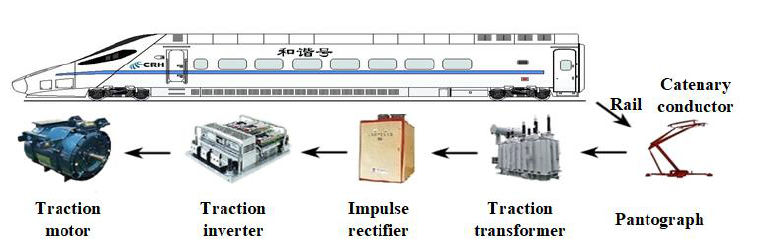
Figure 1. The electric traction system of a CRH